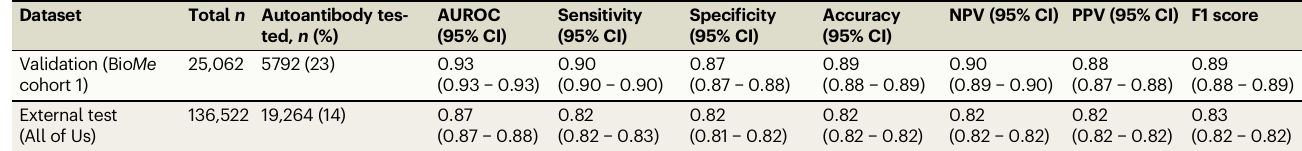
Table 2 | Performance of machine learning model to identify individuals who received autoantibody testing in the validation and external test datasets